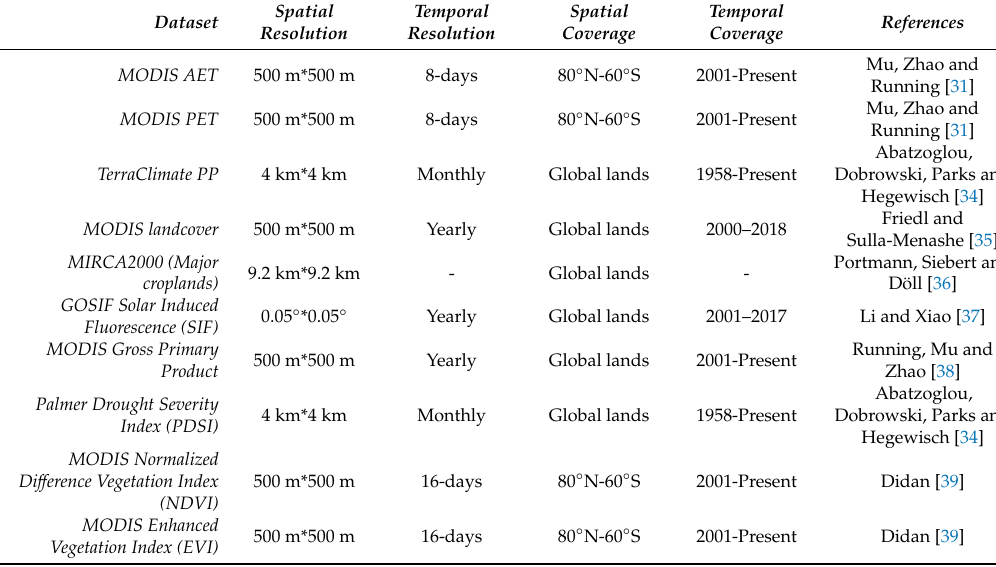
Table 1. Datasets used in the study and their main